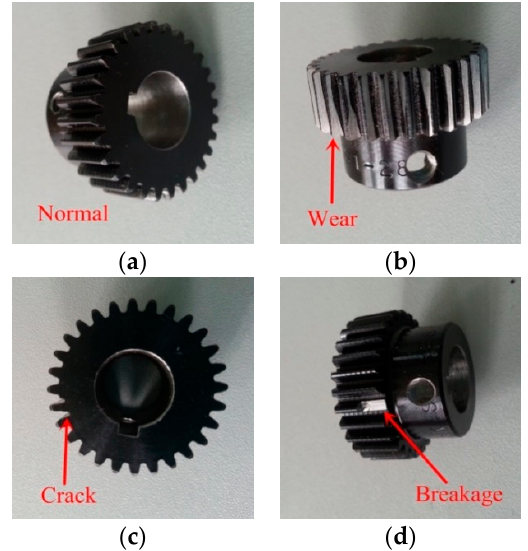
Figure 4. Second-stage sun gears in four states: ( a ) normal gear, ( b ) gear with wear, ( c ) gear with breakage, and ( d ) gear with root crack tooth.